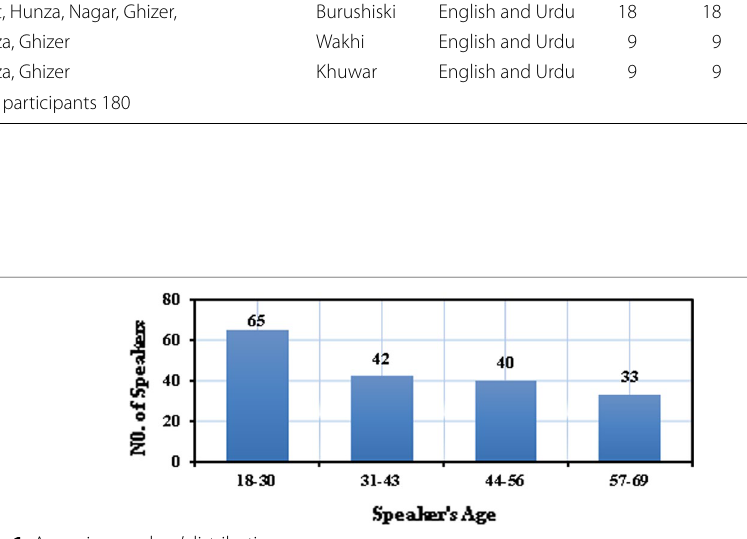
Fig. 1 Age-wise speakers’